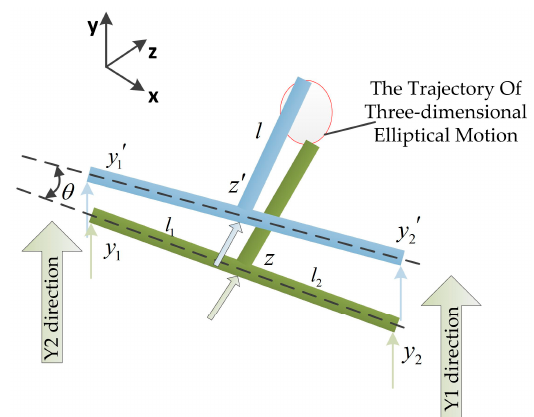
Figure 3. The generation principle of three-dimensional elliptical motion in the tool tip.